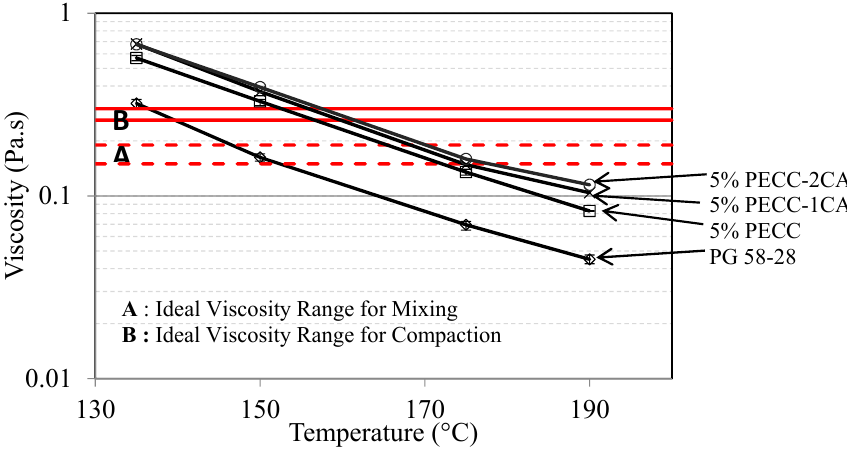
Figure 7. Modified asphalt binder viscosity at high modifier percentage.